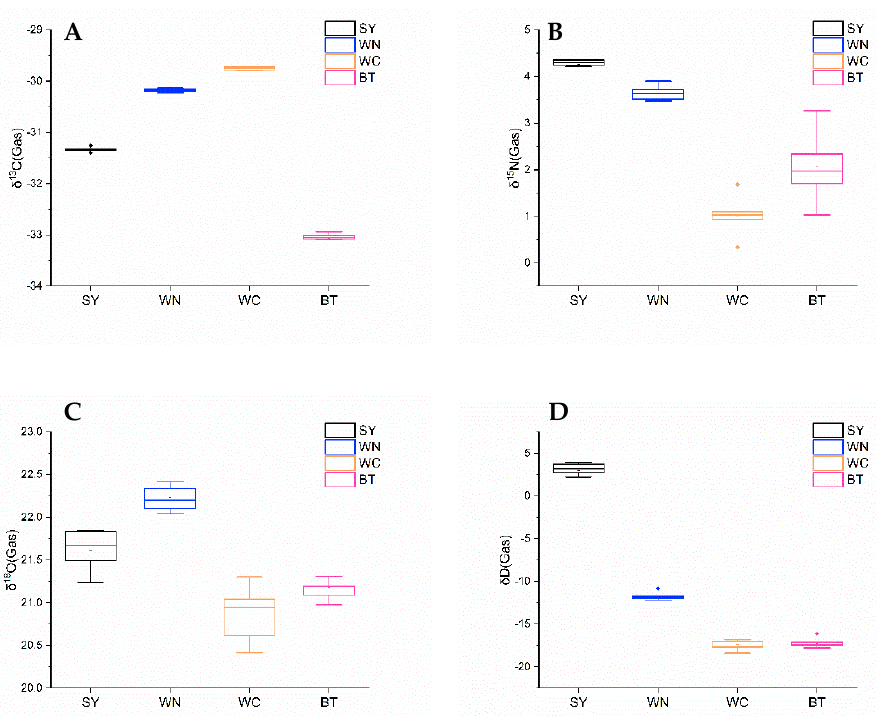
Figure 2. Box plots of δ 13 C ( A ), δ 15 N ( B ), δ 18 O ( C ), and δ D ( D ) of partridge tea from four geographical origins (SY, WN, WC, and BT). In the boxplot, outliers are indicated by asterisks. Outliers are data values that are remote from other data Table 1. The δ 13 C, δ 15 N, δ 18 O, and δ D values of Hainan partridge tea samples from four origins (SY, WN, WC, and BT). Superscripts on different letters indicate significant differences between variables. Geographical